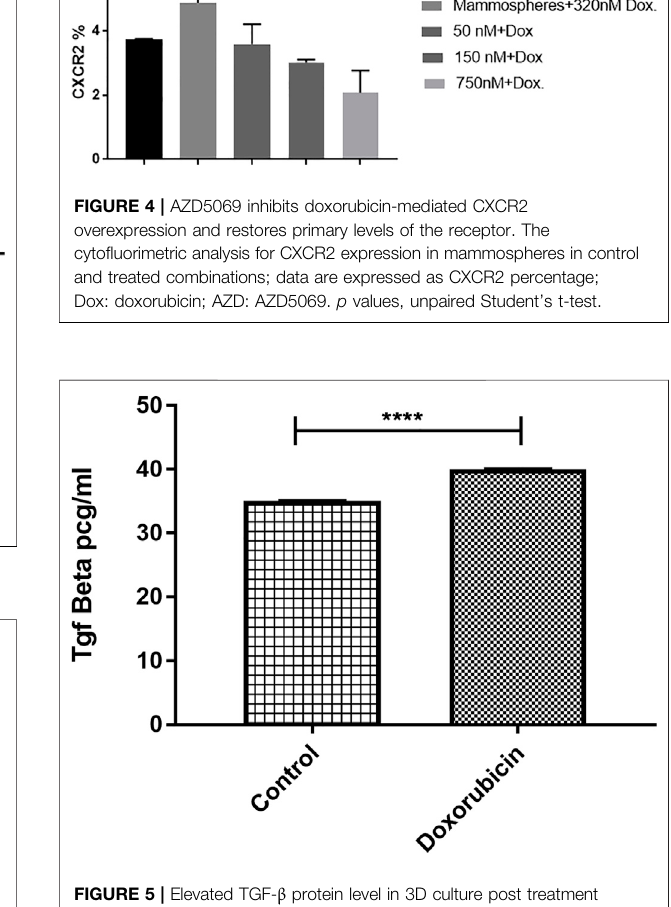
FIGURE 5 | Elevated TGF- β protein level in 3D culture post treatment withdoxorubicin.TGF- β levelsobtainedfromELISAwerecompared incontrol and treatedconditions.Dataareexpressed asTGF- β concentration. p values; unpaired Student ’ s